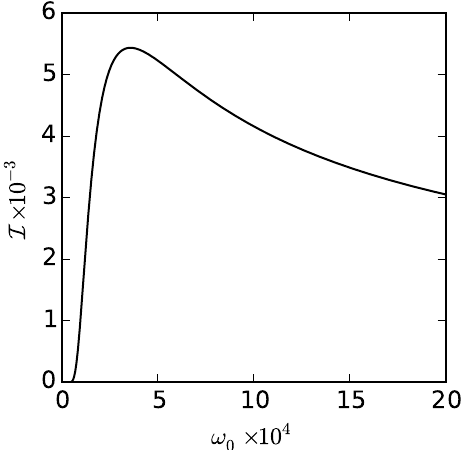
Figure 4. The signal strength as a function of injection trap frequency, ω 0 . After evaporation in a trap with frequency ω ( e ) , the trap potential is adiabatically transformed to ω 0 before the interferometer cycle begins. At the start of the cycle, the trap is snapped to ω = strength peaks at for a non-zero injection frequency ω 0 . For this case, β T 2 = 10 − 4 , and D ( e ) = 10 6 /2 π